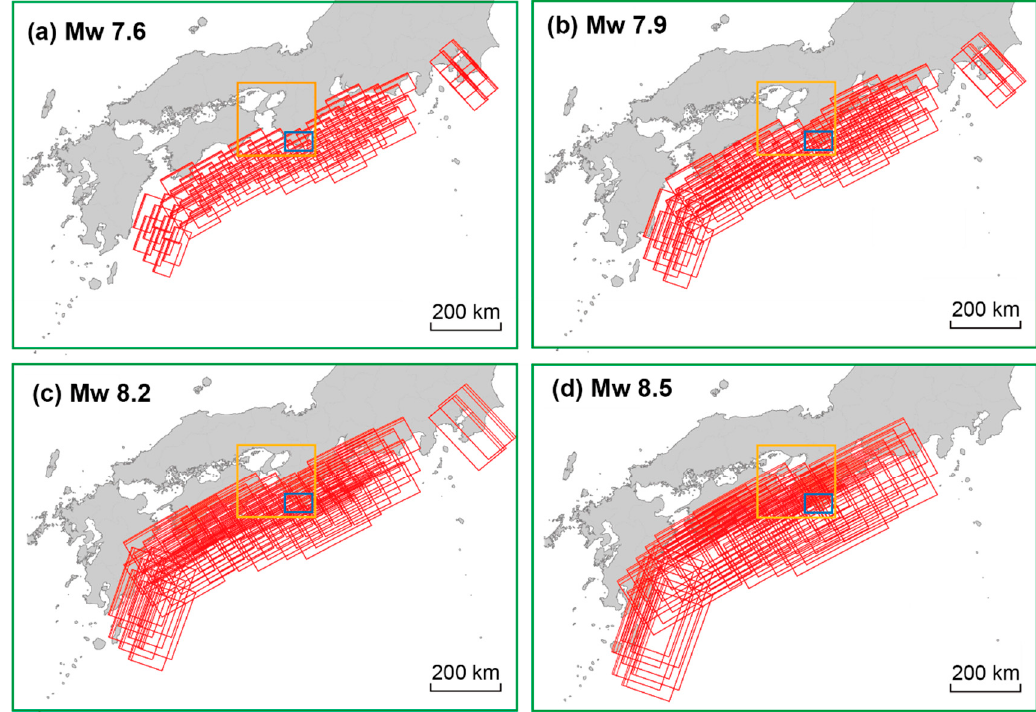
Figure 6. A tsunami source fault model with 1506 types of tsunami scenarios. The solid green line region indicates spatial grid of 810 m, orange line region as 270 m, blue line region as 90 m, ( a ) Earthquake moment magnitude cases of Mw 7.6, ( b ) Mw 7.9, ( c ) Mw 8.2, and ( d ) Mw 8.5.